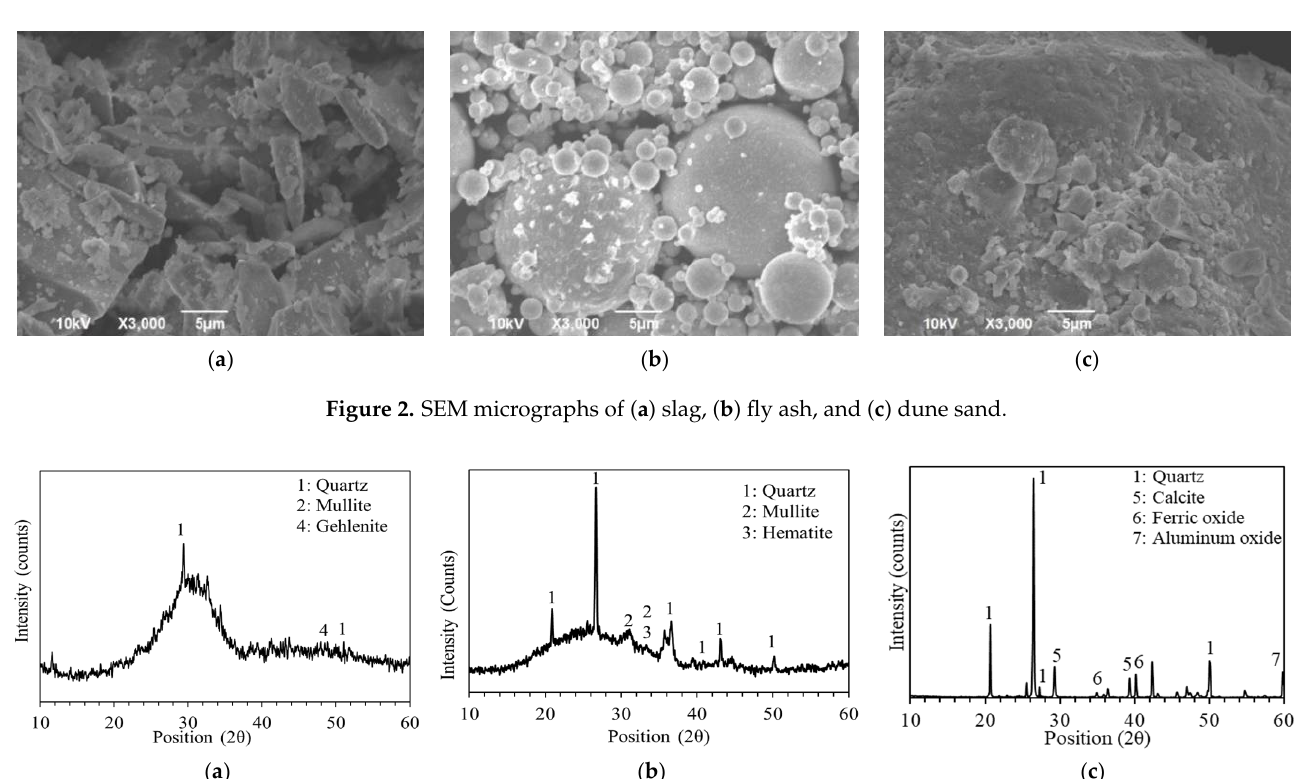
Figure 2. SEM micrographs of ( a ) slag, ( b ) fly ash, and ( c ) dune sand.